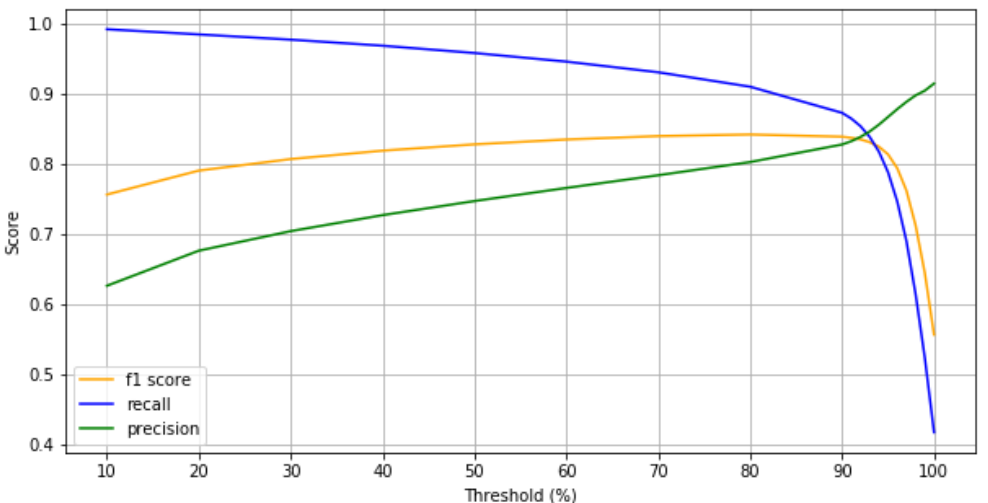
Figure 17. The accuracy variation of entropy-based filtering with fuzzy clustering as the threshold is